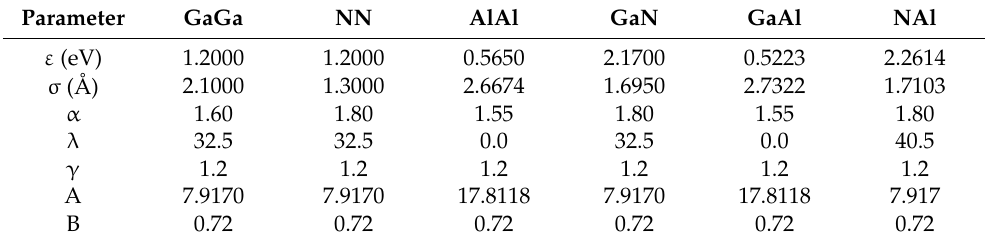
Table 1. Stillinger–Weber potential parameters for the Al-Ga-N systems [30,31]. Parameter